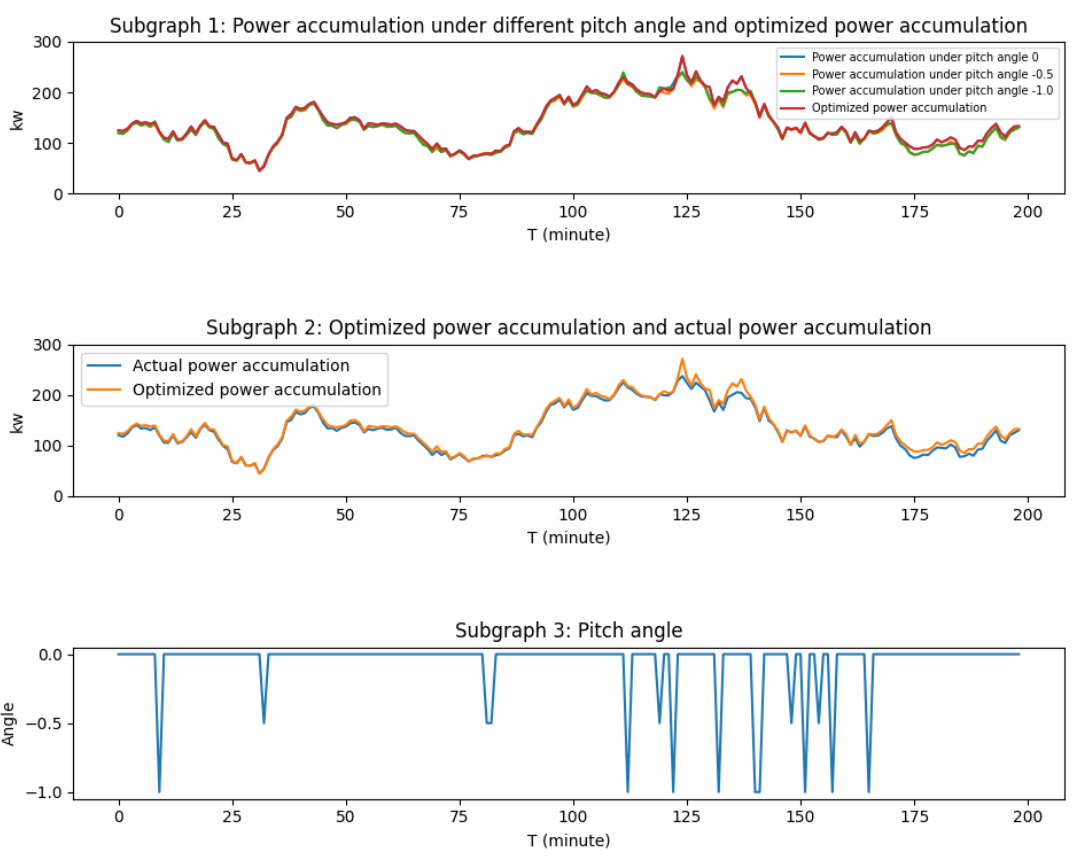
Figure 9. Partial power optimization results on #6 with T = 1 min .